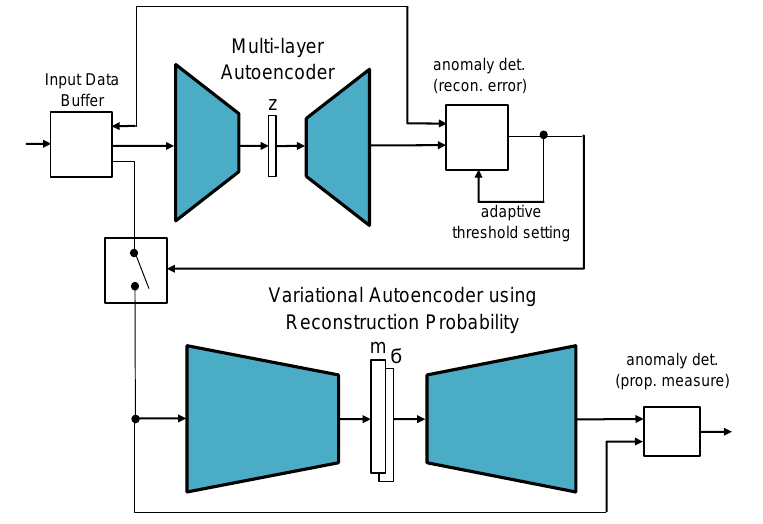
Figure 3. Two-stage anomaly detection with